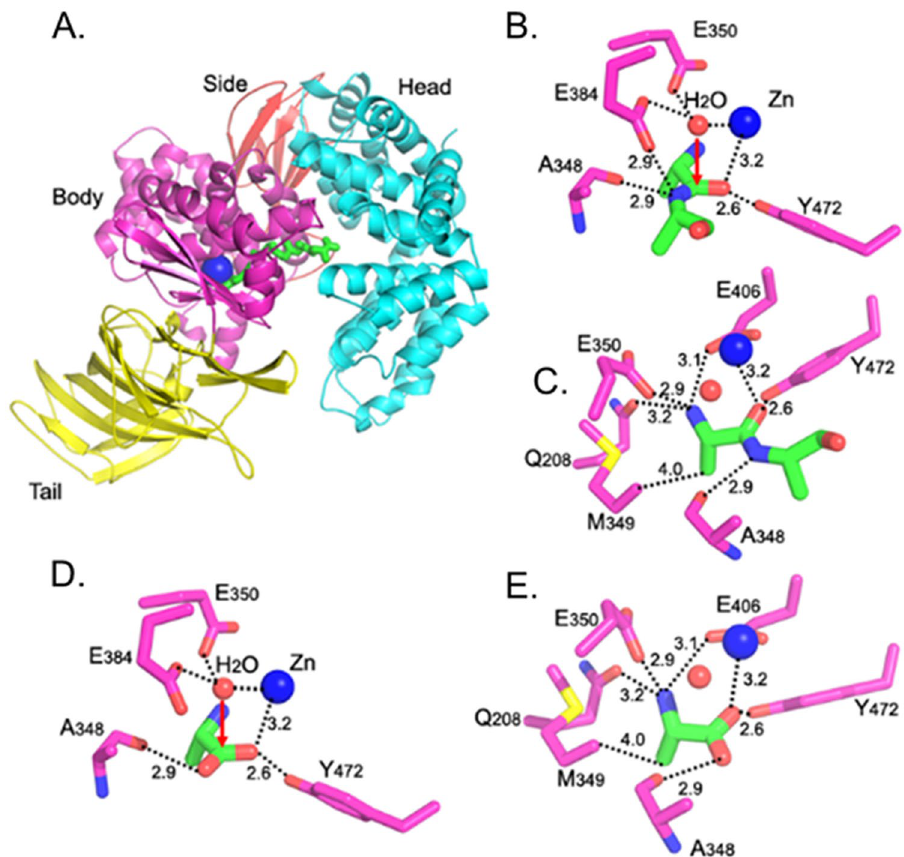
Figure 2. Catalytic mechanism of pAPN. ( A ) Overall structure of pAPN complexed with a peptide substrate (PDB 4FKF). pAPN contains four domains: head (in cyan), side (in brown), body (in magenta), and tail (in yellow). Zinc is shown as a blue ball, and the peptide substrate is in green. ( B ) Interactions between catalytic residues of pAPN (in magenta) and the scissile peptide bond of the peptide substrate (in green). Catalytic water is shown as a red ball. ( C ) Another view of the structure in panel (B) to show all of the interactions between pAPN and the N-terminal residue of the peptide substrate. ( D ) Interactions between catalytic residues of pAPN (in magenta) and product of APN catalysis - free alanine (in green) (PDB 4FKH). ( E ) Another view of the structure in panel (D) to show all the interactions between pAPN and free